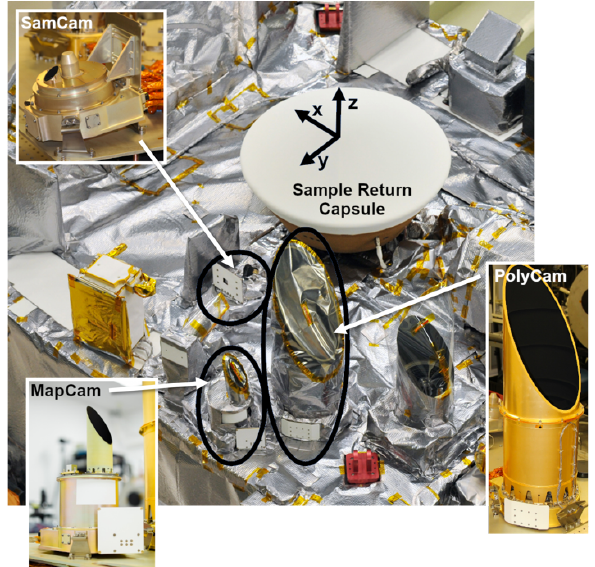
Figure 3. OCAMS mounted to the OSIRIS-REx science deck during thermal vacuum testing (after Rizk et al., 2018). Axes indicate the spacecraft coordinate system. The XY plane lies flush with the science deck. Credits: NASA/Goddard/Lockheed Martin/University of